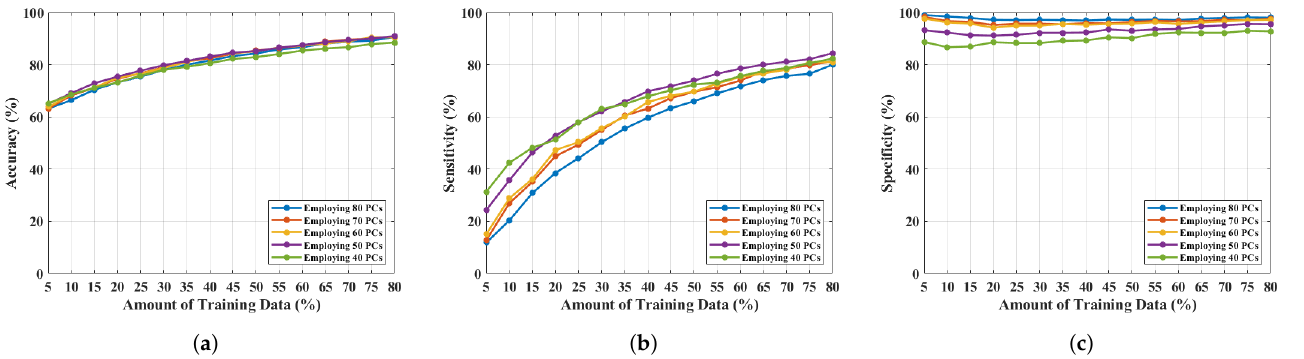
Figure 5. NF and WF breast signal classification results considering PCs measured from Real S 21 and employing SVM RBF , ( a ) accuracy, ( b ) sensitivity, ( c )